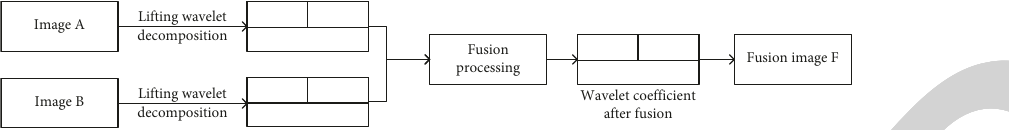
Figure 3: Flow chart of image fusion based on lifting wavelet